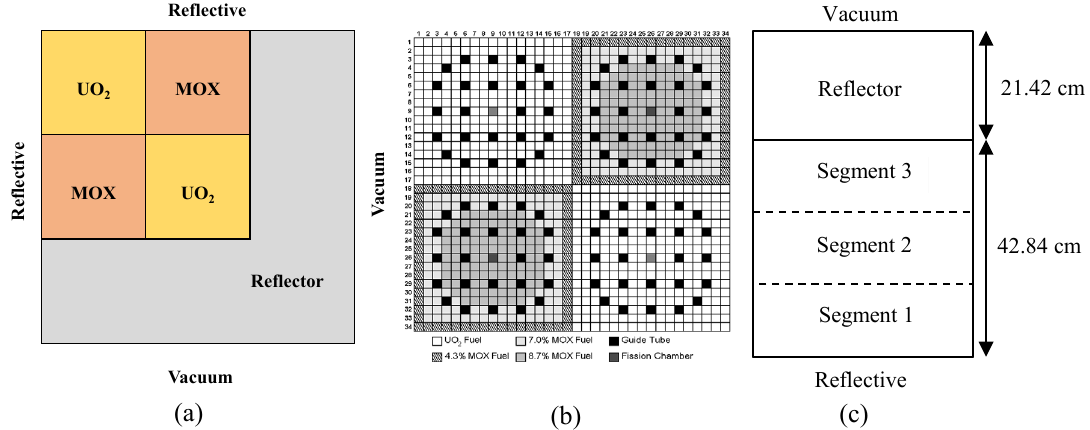
Figure 1. 3-D C5G7 Problem: (a) Radial Configuration, (b) Pin Arrangements in Four Assemblies, and (c) Axial